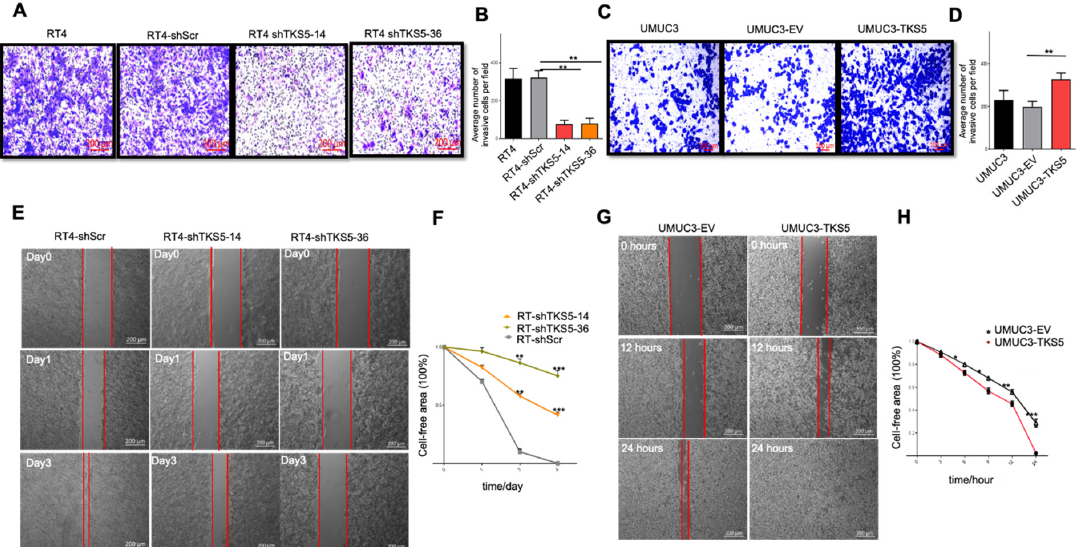
Figure 7. TKS5 regulates invasion and migration abilities of bladder cancer cells. ( A ) Representative images of Boyden chamber experiments showing reduced invasion ability of RT4 cells upon TKS5 knockdown. The red scale bars within the figures indicate 200 µm. ( B ) Quantitation of Boyden chamber experiments presented in ( A ). ( C ) Representative images of Boyden chamber experiments showing increased invasion ability of UMUC-3 cells upon TKS5 overexpression. The red scale bars within the figures indicate 100 µm. ( D ) Quantitation of Boyden chamber experiments presented in ( C ). We took the pictures with a 10× objective lens. We repeated the experiments three times. ( E ) Representative images showing impaired migration ability of RT4 cells upon TKS5 knockdown. The red lines indicate the wound gap and shows the line drawn for image analysis.We took the pictures at three timepoints: day 0, d1 and d3 after removing the insert (i.e., the generation of the wound). The white scale bars within the figures indicate 200 µm. ( F ) Quantitation of results presented in ( E ). ( G ) Representative images showing improved migration ability of UMUC3 cells upon TKS5 overexpression. We took the pictures at three timepoints—0 h, 12 h and 24 h—after removing the insert (i.e., the generation of the wound). The white scale bars within the figures indicate 200 µ m. ( H ) Quantitation of results presented in ( E ). We took the pictures with 5 × and 10 × objective lenses. We repeated the experiments three times. We used Student’s t -test to analyse the statistical significance. Error bars represent mean +/ − SEM (* p < 0.05; ** p < 0.01; *** p <